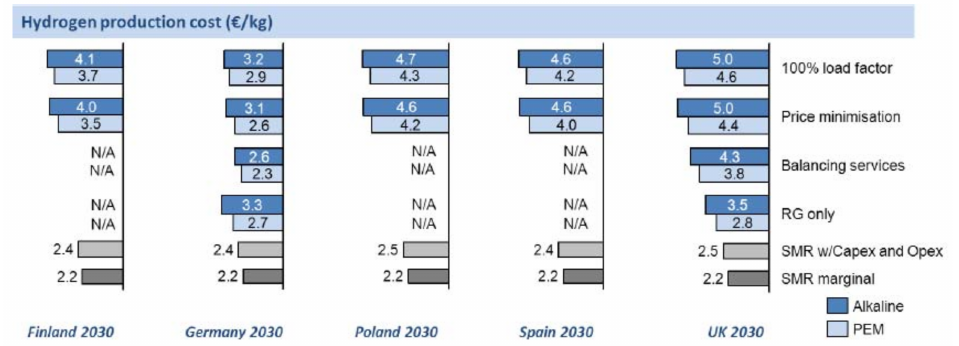
Figure 4. Hydrogen production costs estimated for 2030 for the best case KPIs for Alkaline and PEM electrolyzers in different electricity market scenarios